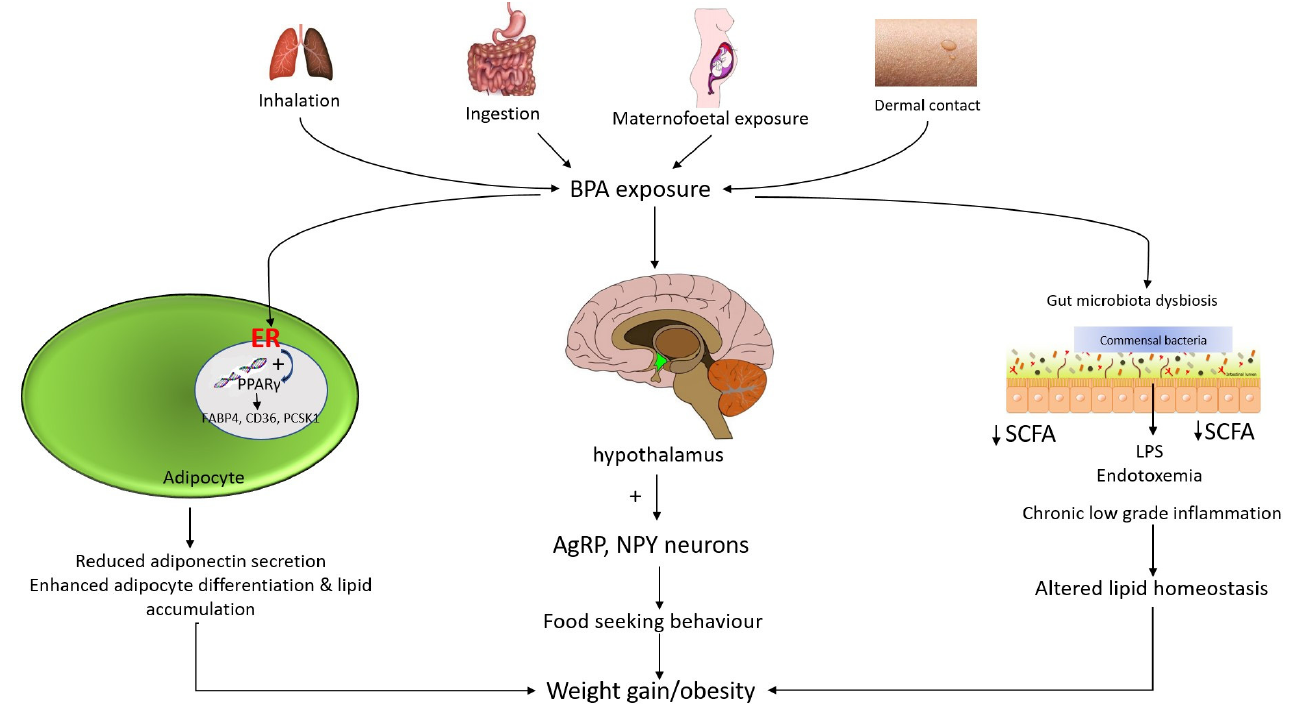
Figure 2. Mechanism of action of bisphenol A and associated obesity. Mechanism of BPA-induced weight gain may be due to its estrogenic activity. BPA binds to estrogen receptors (ER α and ER β ) and subsequently induces a perturbation in peroxisome proliferator-activated receptor gamma (PPAR γ ) signaling. BPA increases the number and size of adipocytes by regulating the expression of genes such as fatty acid binding protein 4 (FABP4), cluster of differentiation 36 (CD36) and proprotein convertase subtilisin/kexin type 1 (PCSK1). In addition, the estrogenic effect of BPA inhibits adiponectin secretion. Meanwhile, in utero and adult exposure to BPA affect the hypothalamic Agouti-related peptide (AgRP) and neuropeptide Y (NPY) neurons. These potent neuropeptides have a stimulating effect on the appetite. BPA that accumulates in the gut may contribute to gut bacterial dysbiosis. BPA exposure reduces gut small chain fatty acid (SCFA) and increases systemic lipopolysaccharide (LPS) levels, leading to chronic low-grade inflammation and subsequently altered lipid homeostasis.